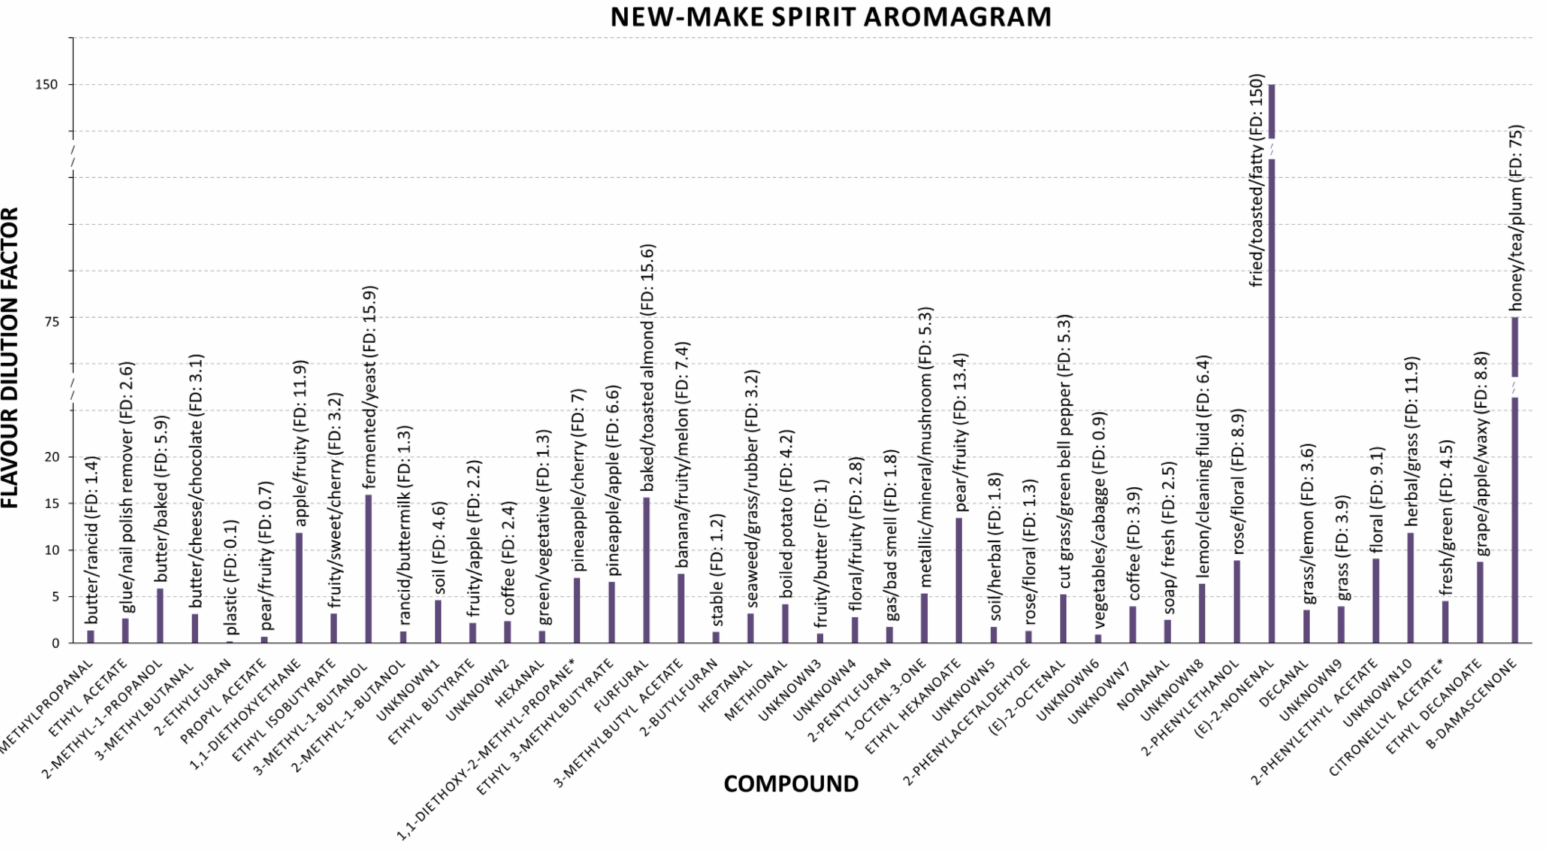
Figure 1. Aromagram of new make spirits illustrating the compounds, the mean value of flavour dilution factors (FD), and the odours of the compounds obtained by GCO